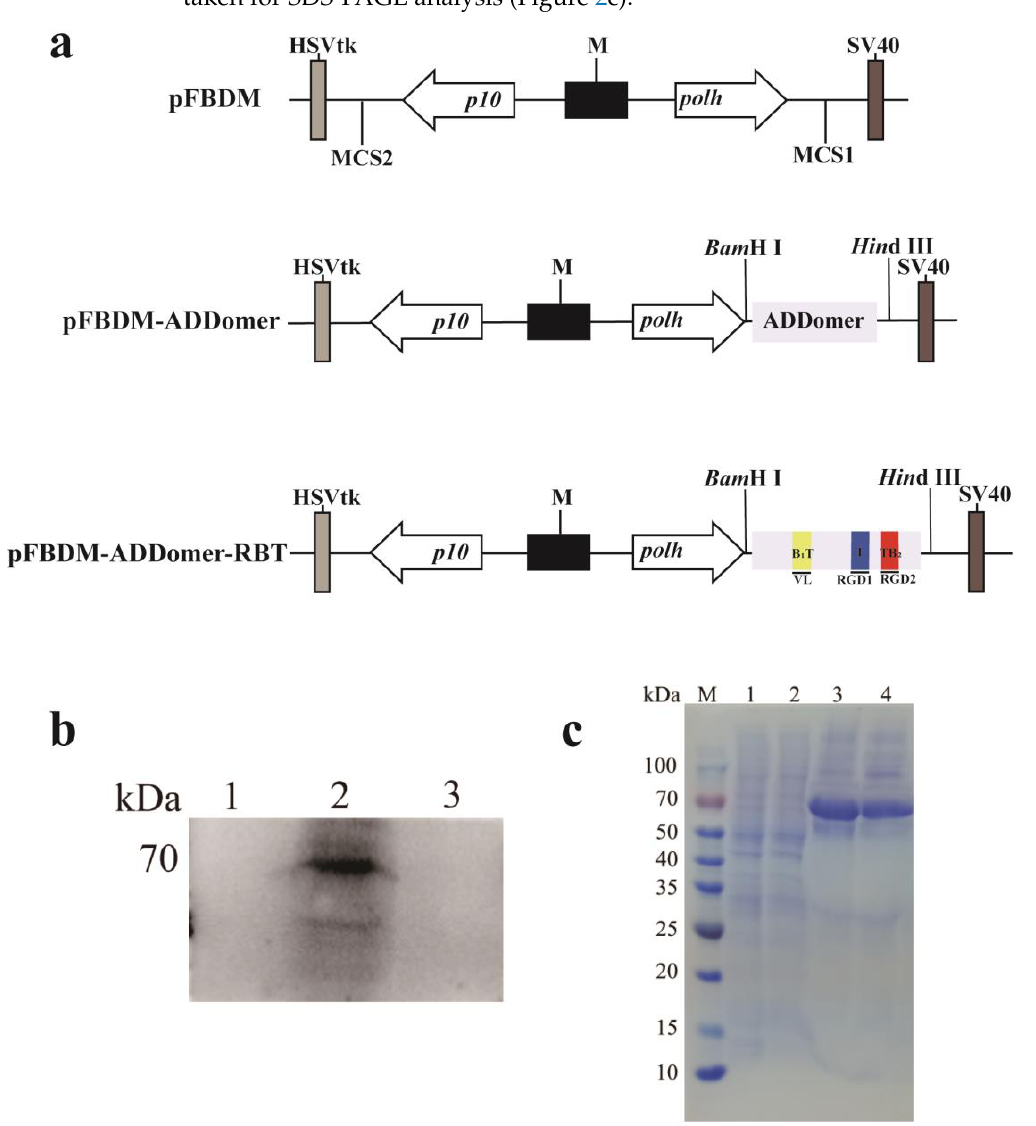
Figure 2. Construction and acquisition of recombinant proteins. ( a ) Construction diagram of pFBDM-ADDomer and pFBDM-ADDomer-RBT recombinant transfer vectors. ( b ) Western blot analysis of recombinant protein expression in Sf9 cells producing recombinant baculovirus. Lane 1: cell lysates of Ac-ADDomer; lane 2: cell lysates of Ac-ADDomer-RBT; channel 3: cell lysates of normal sf9 cells as a negative control. The primary antibody is the FMDV positive sera, and the secondary antibody is the Rabbit anti-porcine IgG-HRP. ( c ) SDS-PAGE analysis of sucrose gradient centrifuged protein loops (30 to 50%, produced by Hi5 cells). Lane 1: ADDomer proteins before sucrose gradient purification. Lane 2: ADDomer-RBT proteins before sucrose gradient purification. Lane 3: after purification of ADDomer proteins. Lane 4: after purification of ADDomer-RBT